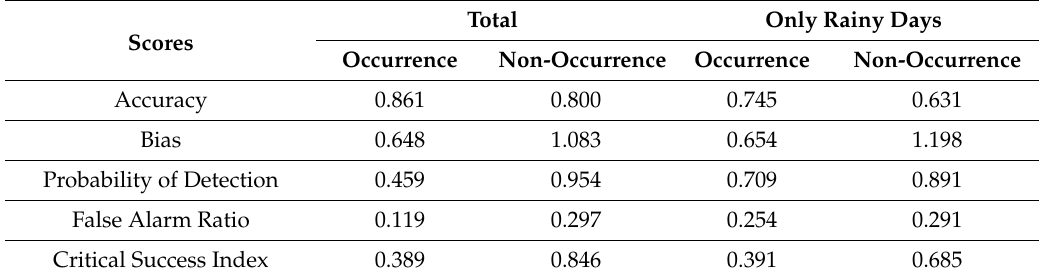
Table 2. Average scores calculated for occurrence / non-occurrence flash flood events with unconditional (total) and conditional rainy